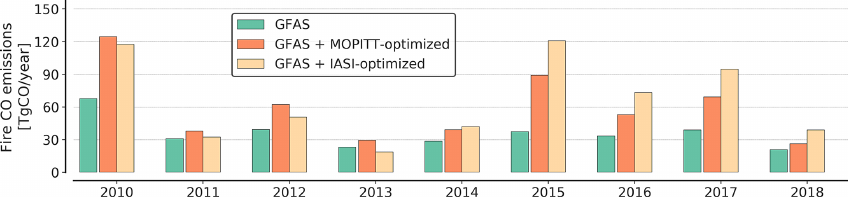
Figure 7. Total CO emissions from biomass burning summed over the 1 ◦ × 1 ◦ South American zoom domain and over the April–December inversion period. Results for two sets of inversions are shown, which each started from the GFAS fire prior: the first is the default inversion that used MOPITT satellite data, and the second used IASI satellite data.